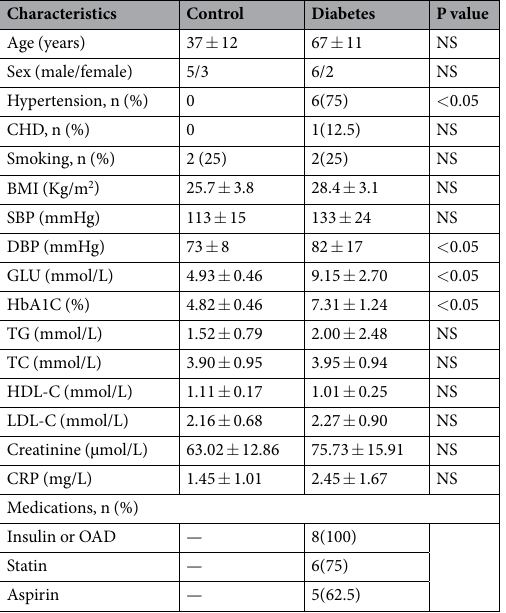
Table 2. Table Clinical characteristics of patients. The data are given as the mean ± SD. or number of patients. CHD: coronary heart disease; BMI: body mass index; SBP: systolic blood pressure; DBP: diastolic blood pressure; GLU: fasting glucose; TC: total cholesterol; TG: total triglycerides; LDL-C: low-density lipoprotein cholesterol; HDL-C: high-density lipoprotein cholesterol; CRP: C-reactive protein; OAD: oral antidiabetic